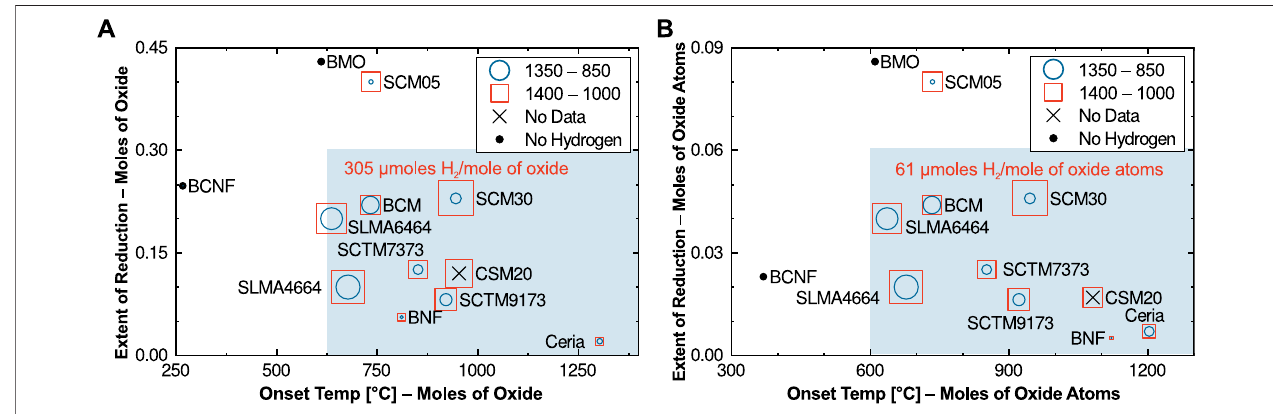
FIGURE 6 | Comparison of water-splitting hydrogen yields for new compositions, along with other published results from same facility, using both normalizations; (A) moles of oxide, and (B) moles of oxide atoms. Symbol sizes represent the magnitude of hydrogen produced during actual water-splitting for two different redox temperature pairs. The maximum production, SCM30 under the higher temperature conditions, is listed on the plot for scale. Shading indicates the target window for onset temperature and extent of reduction (McDaniel et al., 2013; Barcellos et al., 2018; Barcellos et al., 2019; Bergeson-Keller et al., 2022).